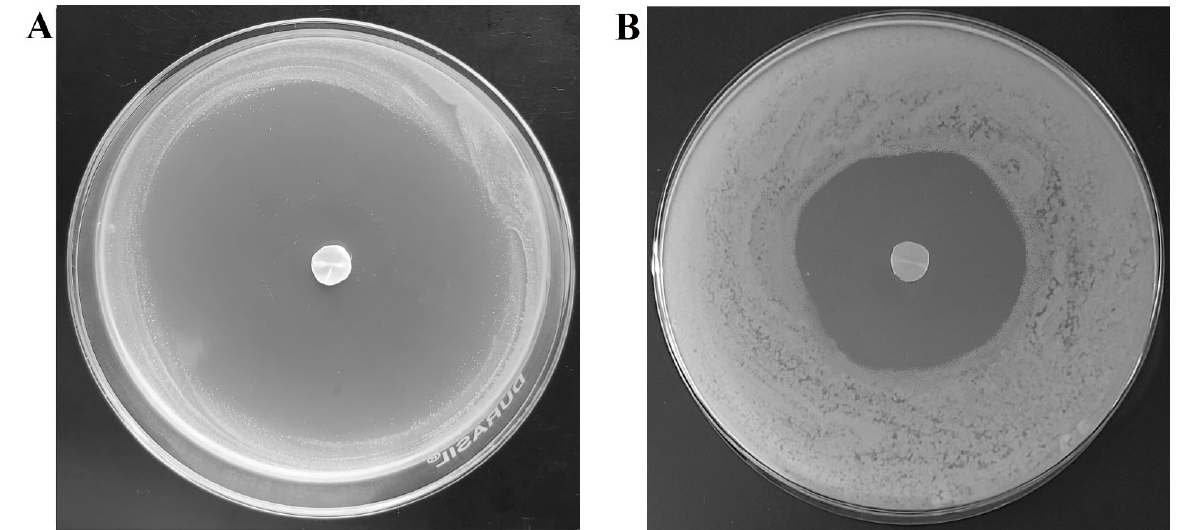
Figure 13. Photographic images showing antifungal efficacy by the drug-accumulated nail plates at day 4 by ( A ) iontophoresis and ( B ) passive process. The drug accumulation into the nail tissue was done with optimized formulation (F8) using iontophoresis (12 V for 6 h) and passive process (0 V for 6 h).